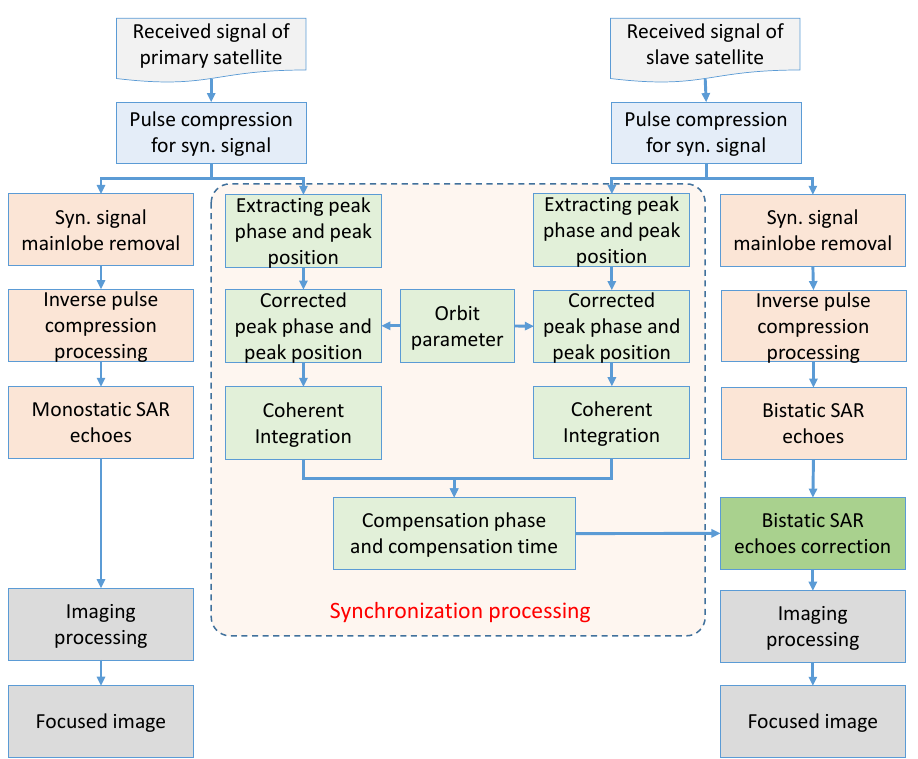
Figure 8. The processing flowchart of the proposed synchronization